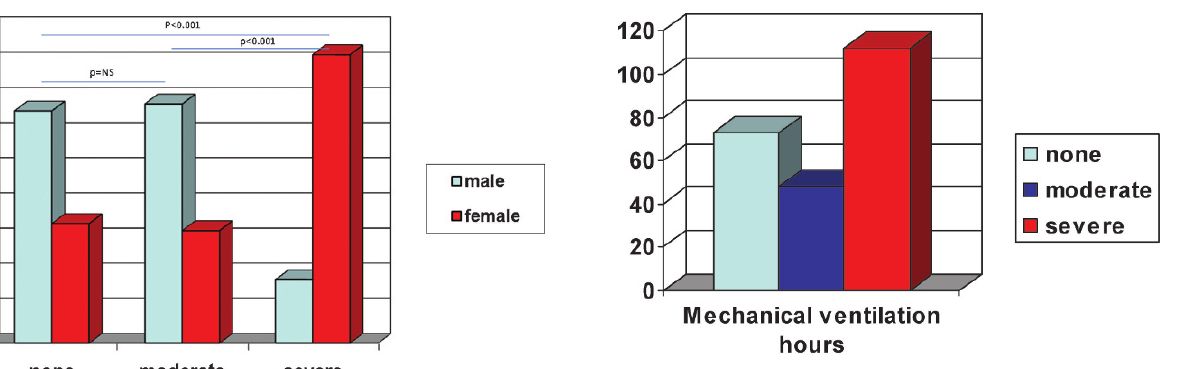
Figure 3 - Hours of mechanical ventilation according to the severity of patient-prosthesis mismatch.